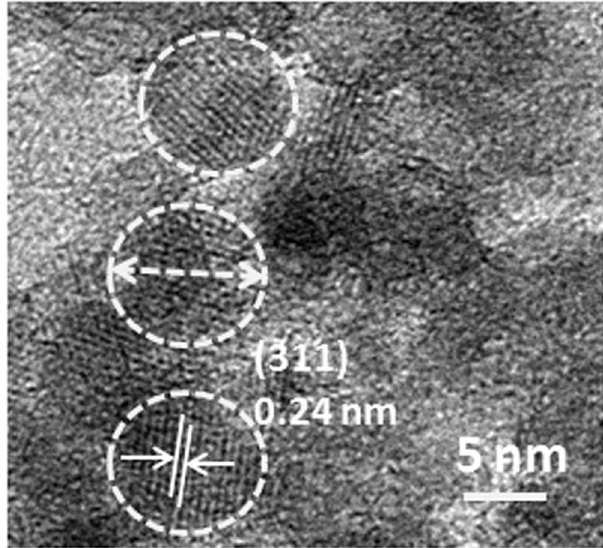
Figure 5. High resolution transmission electron microscopy result of CoFe 2 O 4